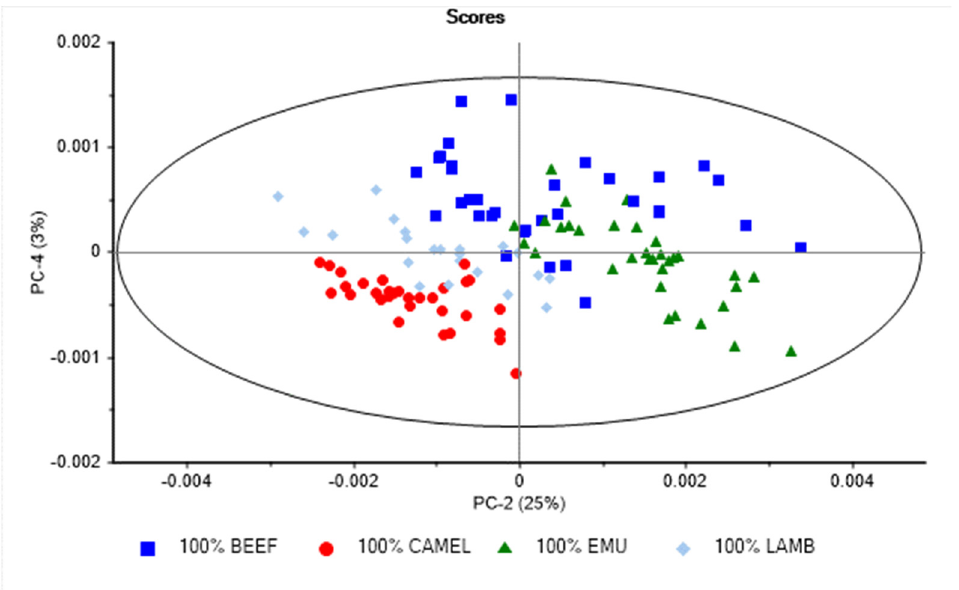
Figure 2. Principal component score plot of NIR spectra of lamb ( Ovis aries ), emu ( Dromaius novaehollandiae ), camel ( Camelus dromedarius ), and beef ( Bos taurus ) minced samples analyzed using a portable NIR instrument.